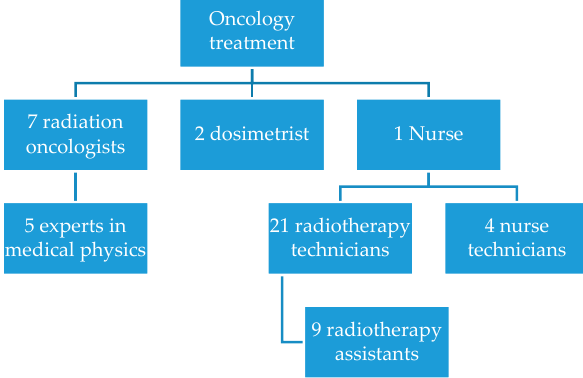
Figure 4. Number of professionals in the radiotherapy sector.